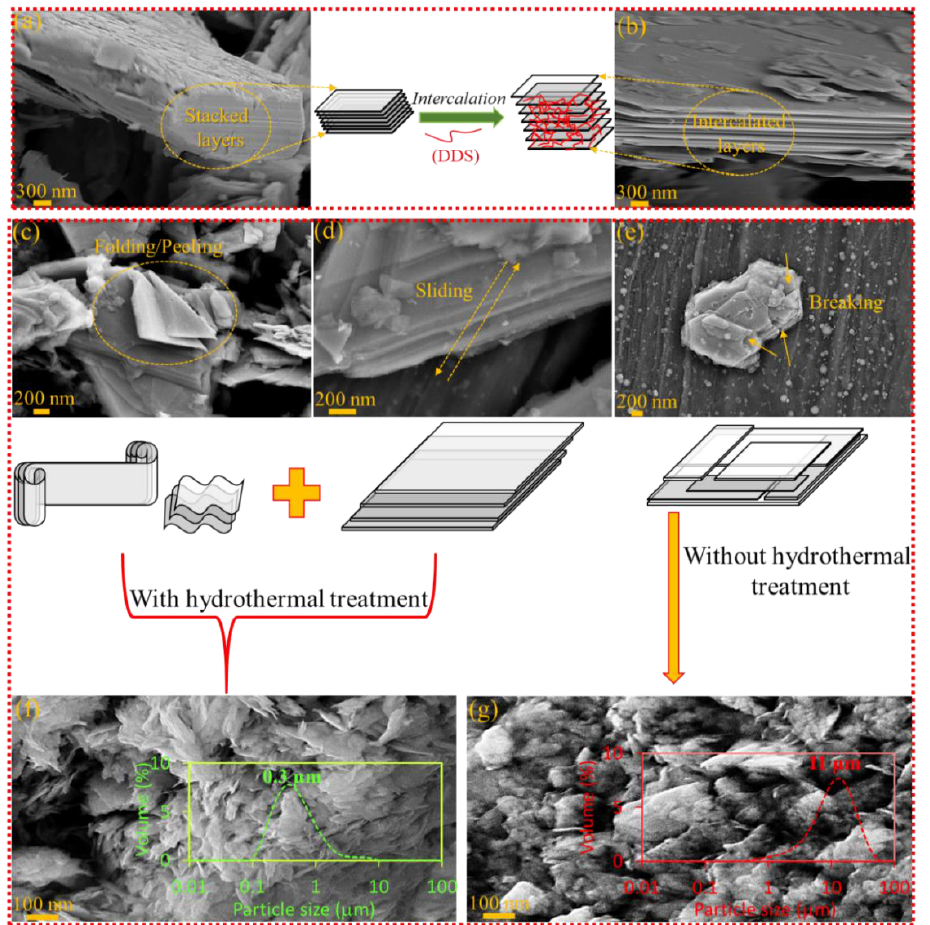
Figure 2. ( a–g ) Schematic presentations, SEM images of mechanisms and particle size distribution